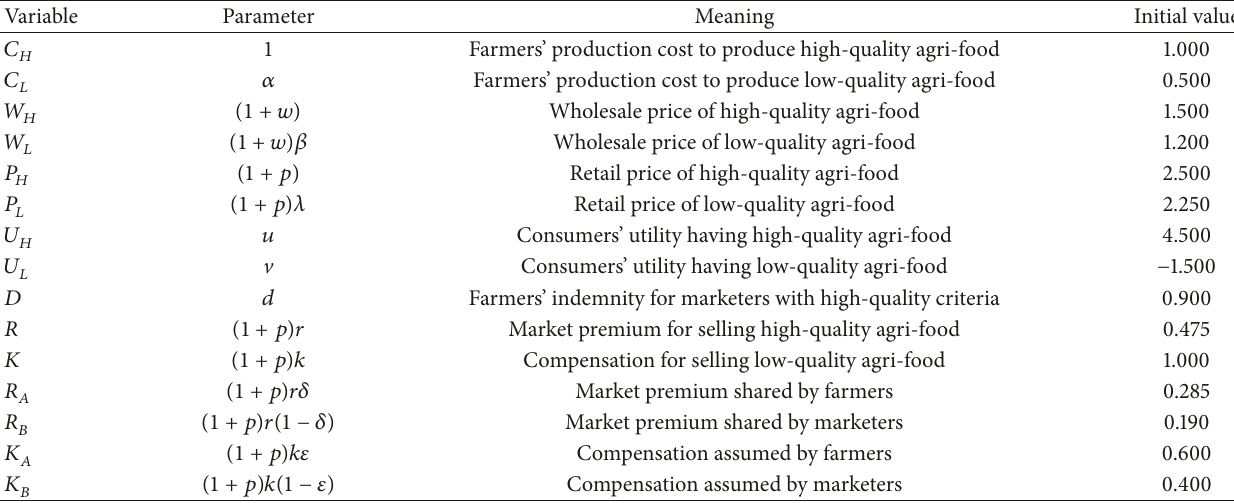
Table 5: Initial values of parameters.